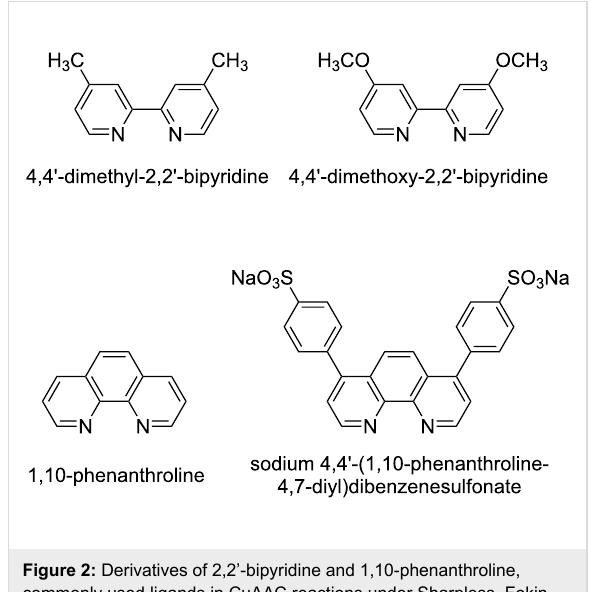
Figure 2: Derivatives of 2,2’-bipyridine and 1,10-phenanthroline, commonly used ligands in CuAAC reactions under Sharpless–Fokin conditions